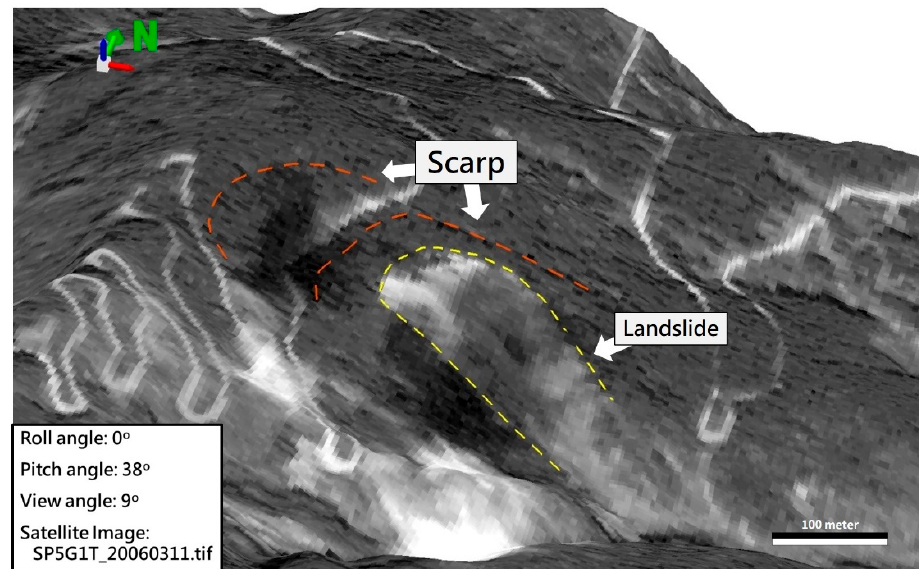
Figure 8. The SPOT5 image after 2005 event was overlaid on DTM5 three-dimensionally, viewing from west direction toward east direction, and lineaments of landslide scarp mapped were shown as the colored dash lines.